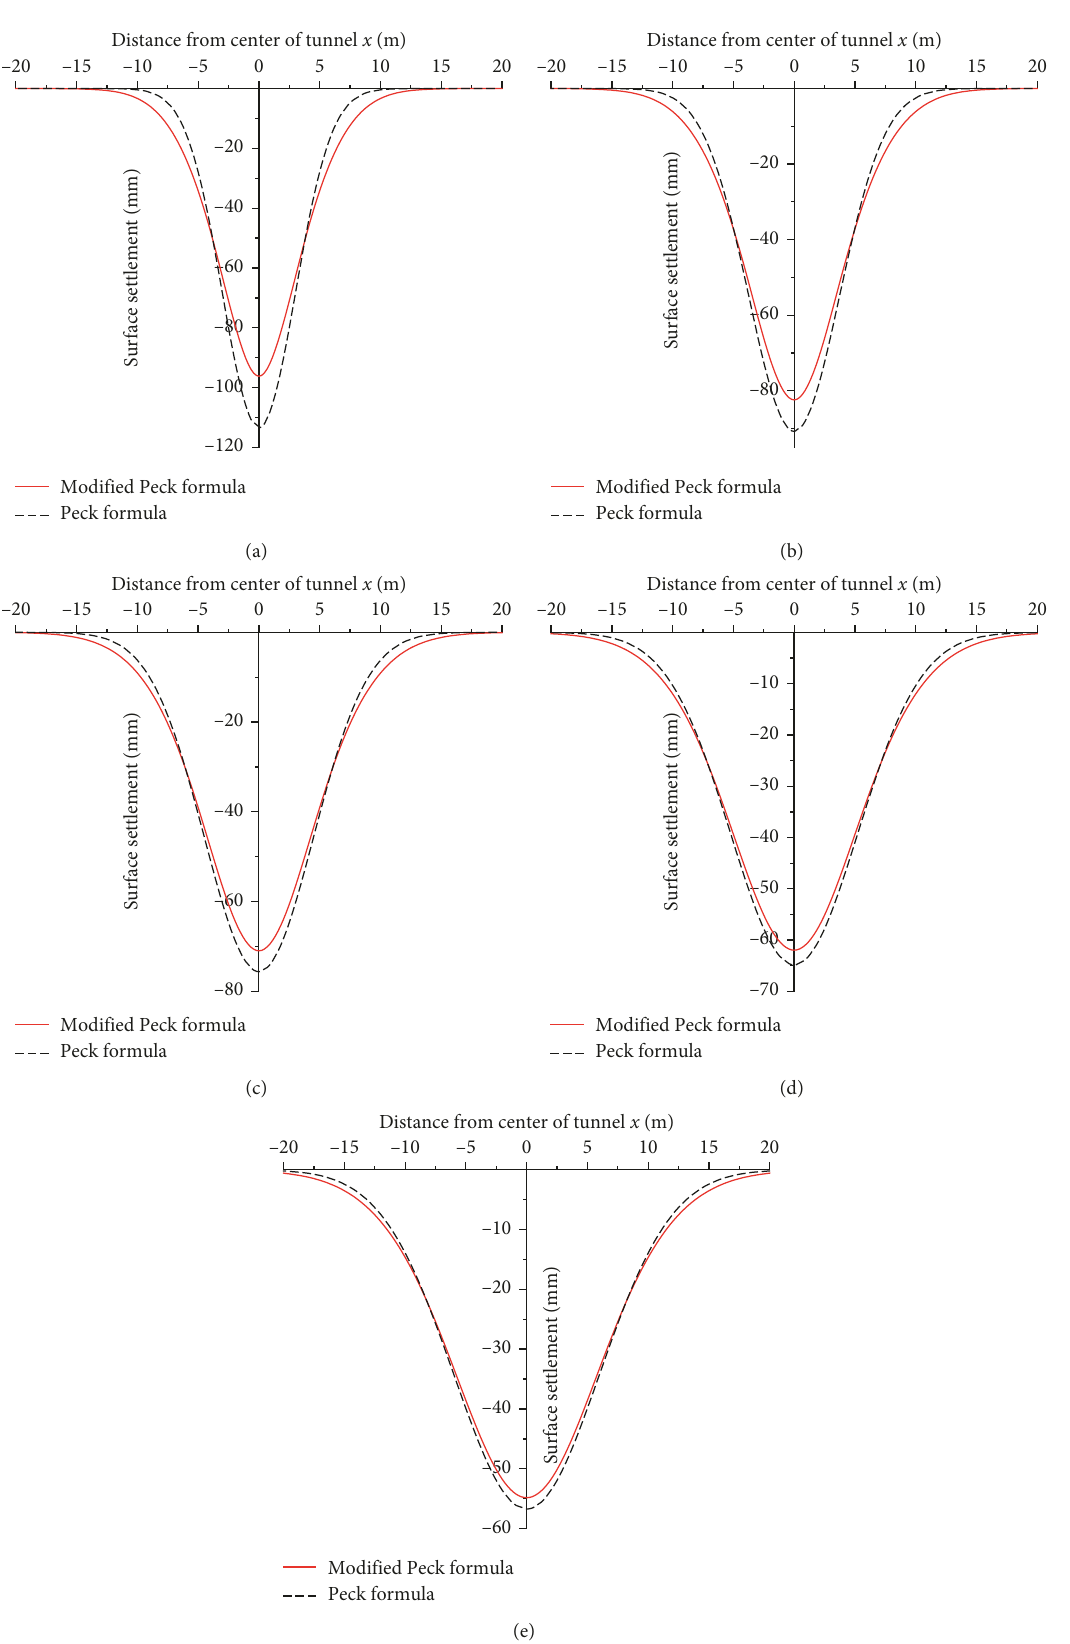
Figure 7: Comparison of calculation results of surface settlement curves of different tunnel depths: (a) Z � 6m; (b) Z � 7.5m; (c) Z � 9m; (d) Z � 10.5 m; (e) Z �